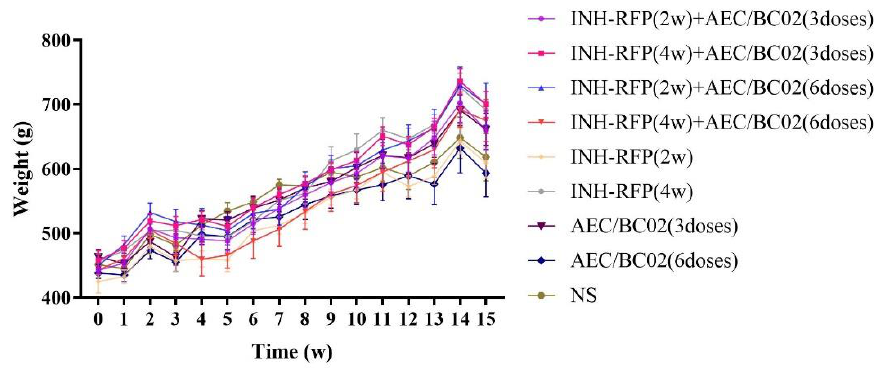
Figure 2. Changes in guinea pig body weight over time (mean ±